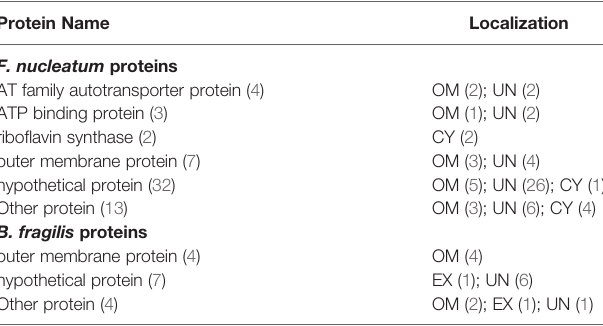
TABLE 2 | Vaxign predicted no human homology proteins as potential CRC virulence factors.